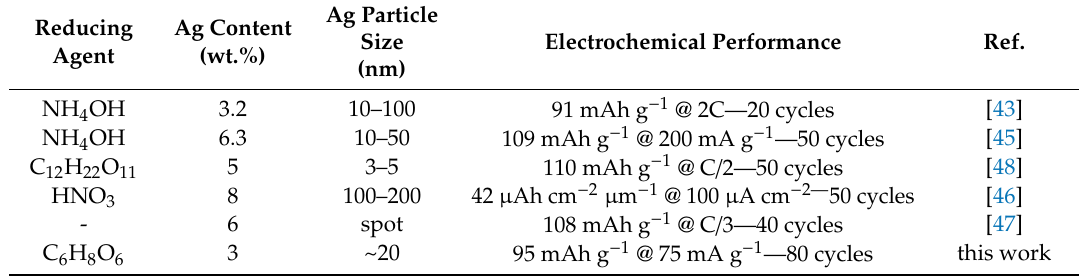
Table7. ComparisonoftheelectrochemicalperformanceofAg-modifiedLiMn 2 O 4